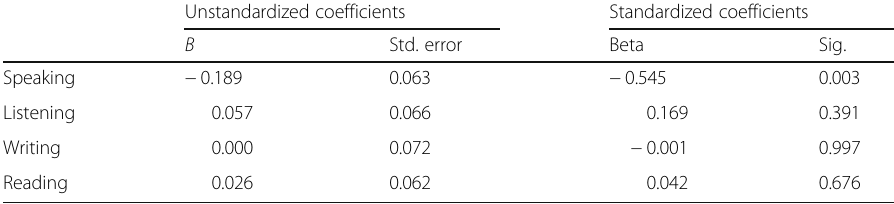
Table 7 The results of multiple regression analysis for the language proficiency subskills and